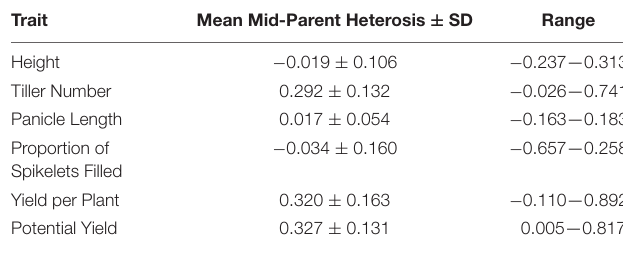
TABLE 9 | Mean, standard deviation, and range of mid-parent heterosis for each